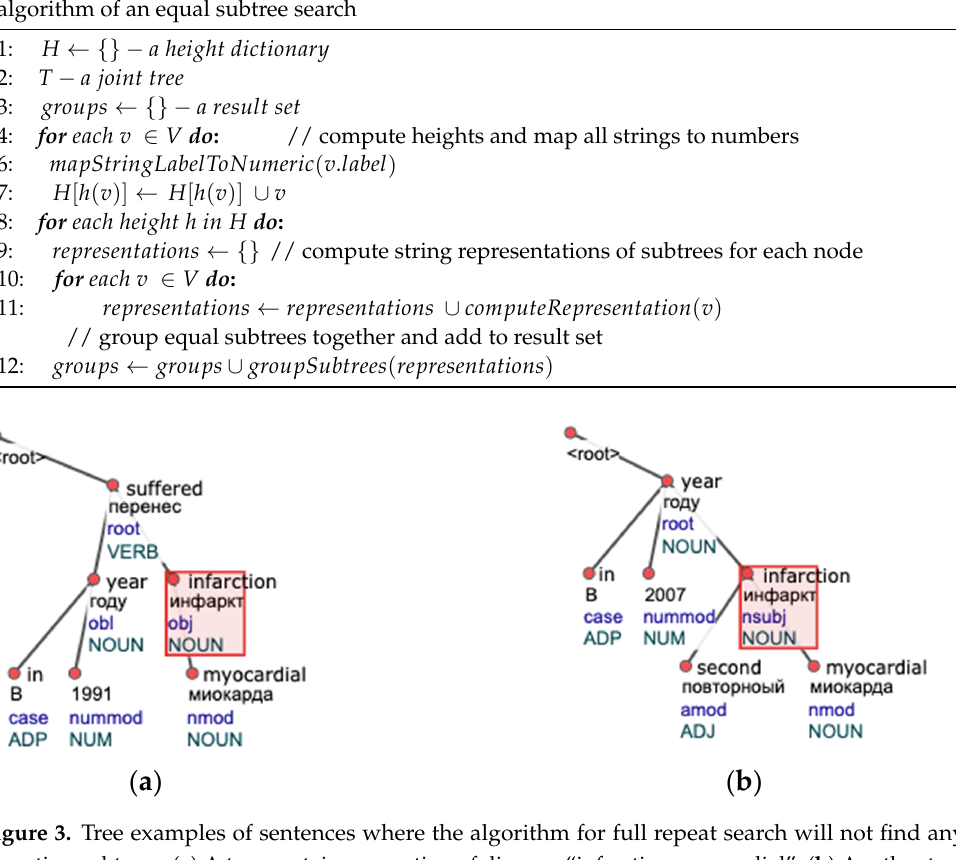
6 of 19 Algorithm 1: Main idea of the base algorithm of an equal subtree search in pseudocode. The base algorithm of an equal subtree search 1: (cid:1834) ← {} − (cid:1853) ℎ(cid:1857)(cid:1861)(cid:1859)ℎ(cid:1872) (cid:1856)(cid:1861)(cid:1855)(cid:1872)(cid:1861)(cid:1867)(cid:1866)(cid:1853)(cid:1870)(cid:1877) 2: (cid:1846) − (cid:1853) (cid:1862)(cid:1867)(cid:1861)(cid:1866)(cid:1872) (cid:1872)(cid:1870)(cid:1857)(cid:1857)